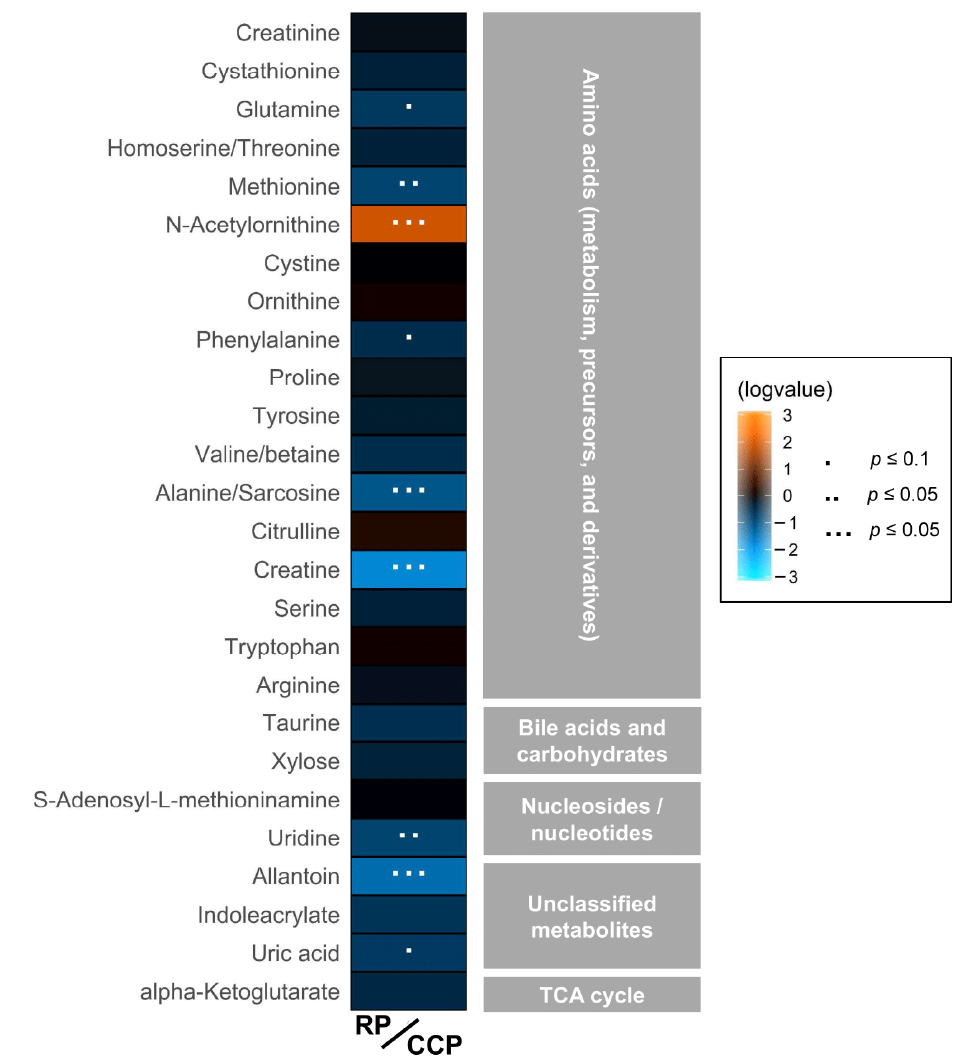
Figure 2. Heatmap showing increased or decreased abundance of detected metabolites organized by compound class between the RP ( n = 20) and the CCP ( n = 68; fold change of RP/CCP). Eight compounds exhibited significantly lower abundance while one compound showed significantly higher abundance during the